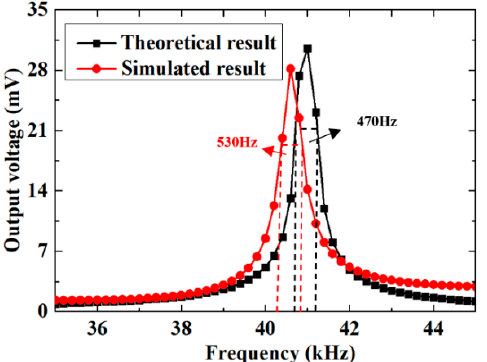
Figure 4. The simulation results of sound pressure level.